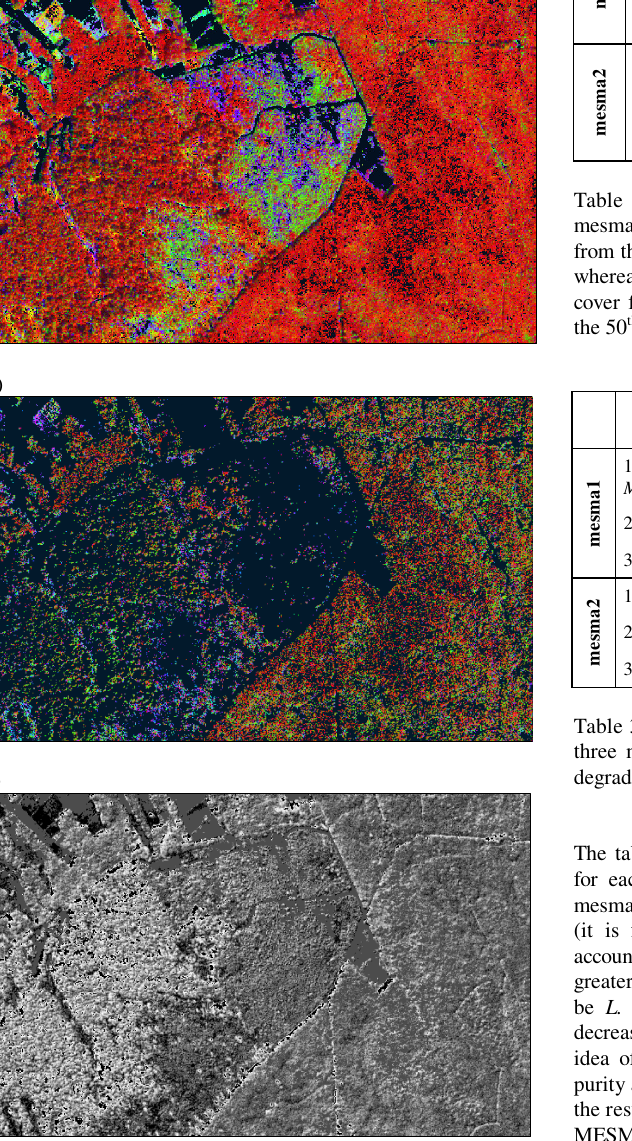
Figure 3. Results obtained from MESMA. Colored images represent combinations of three endmembers corresponding to species or group of species used in the analysis; each color intensity correlates to the cover fraction of the species. a) mesma1: M. faya + L. novocanariensis (RED), E. arborea (GREEN) and fern-herbaceous (BLUE). b) mesma2: M. faya (RED), L. novocanariensis (GREEN) and P.radiata (BLUE). c) Shade fractions estimates, darker cells corresponding to lower proportion of shade.